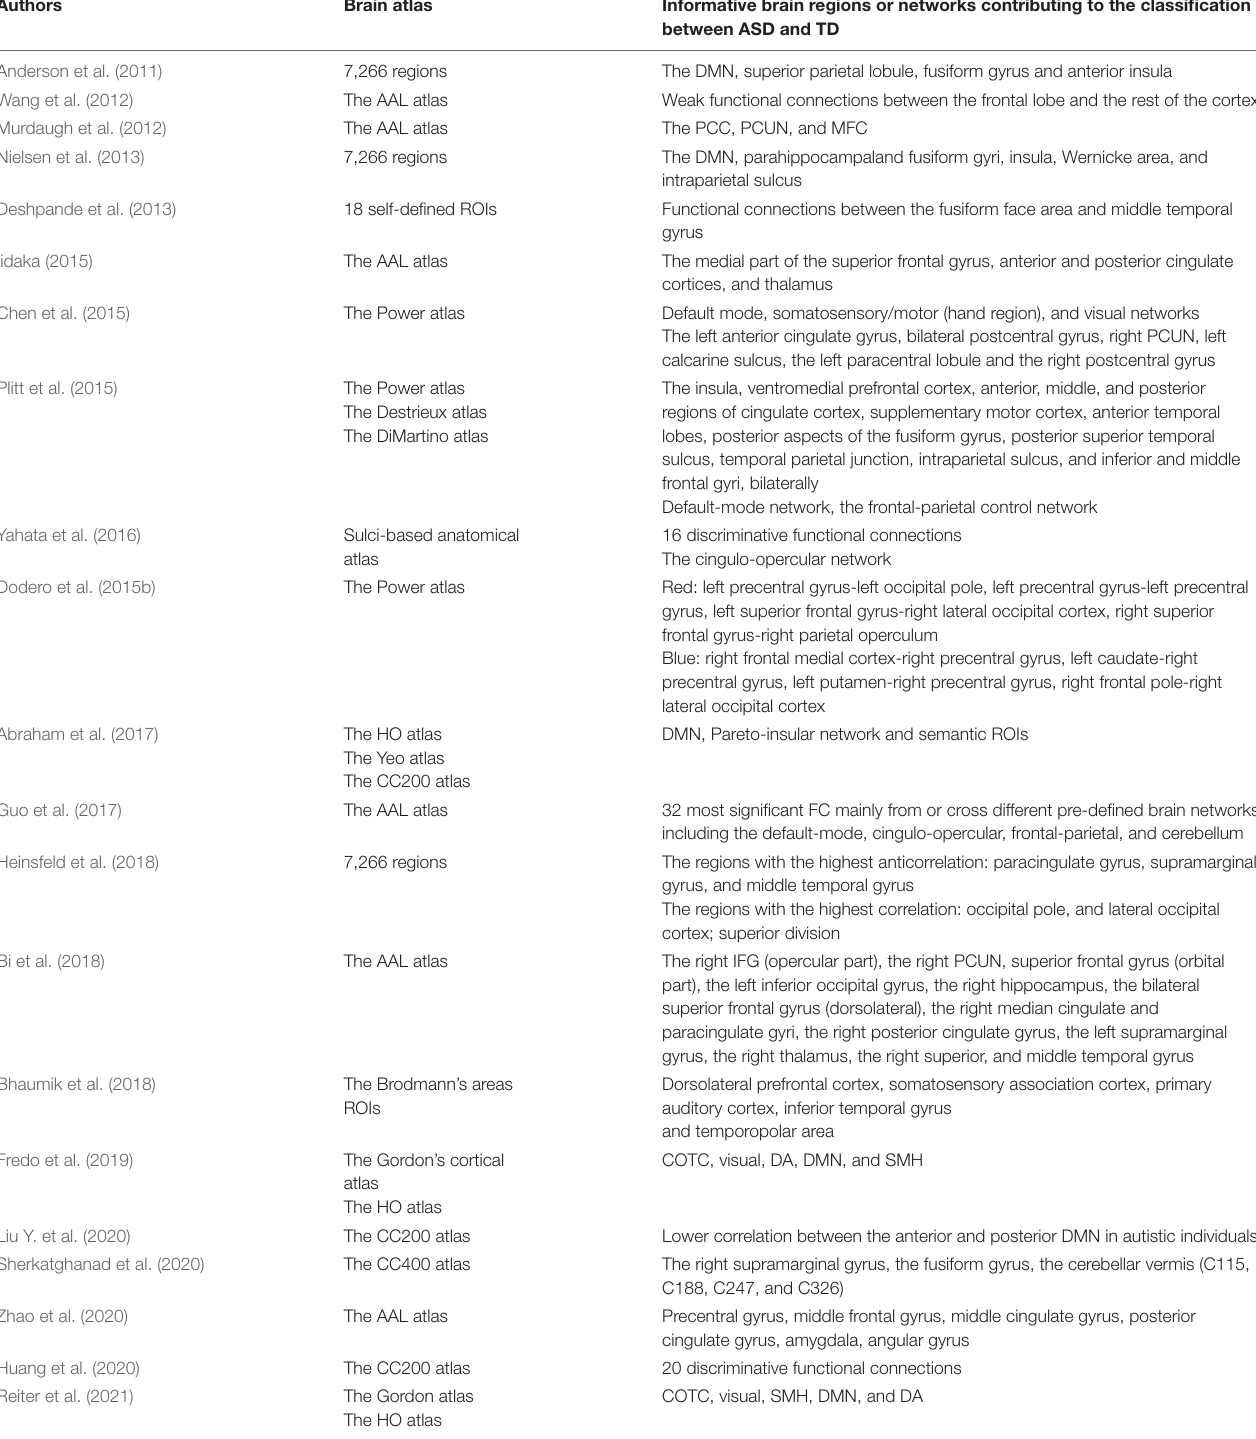
TABLE 3 | Summary of informative brain regions or networks determined by classification between ASD and TD using FCs as features.